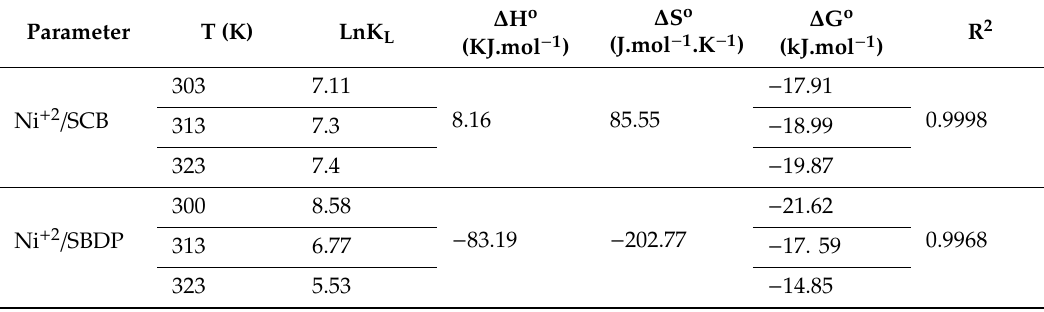
Table 3. Thermal parameters for the adsorption of 1 g / L of Ni ions by 0.3g / 50 mL of nanocomposite at a pH of 8 and a contact time of 40 min.